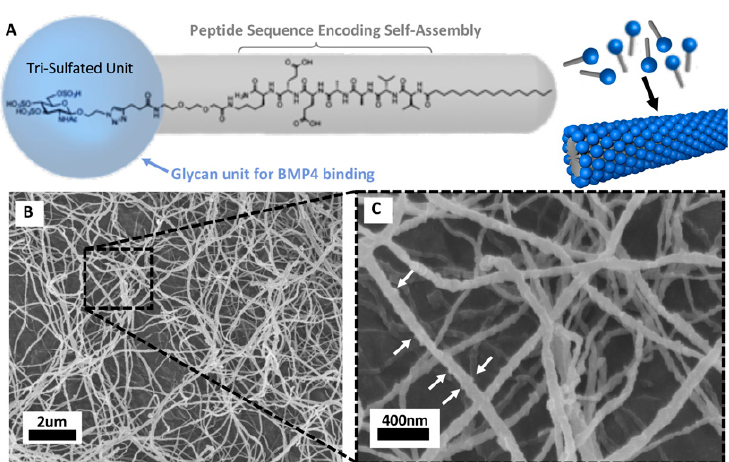
Figure 5. Peptide amphiphile (PA) nanostructures are novel biocompatible materials for BMP4 delivery. ( A ) Molecular structure of a glycosylated PA molecule and schematic of the self-assembled